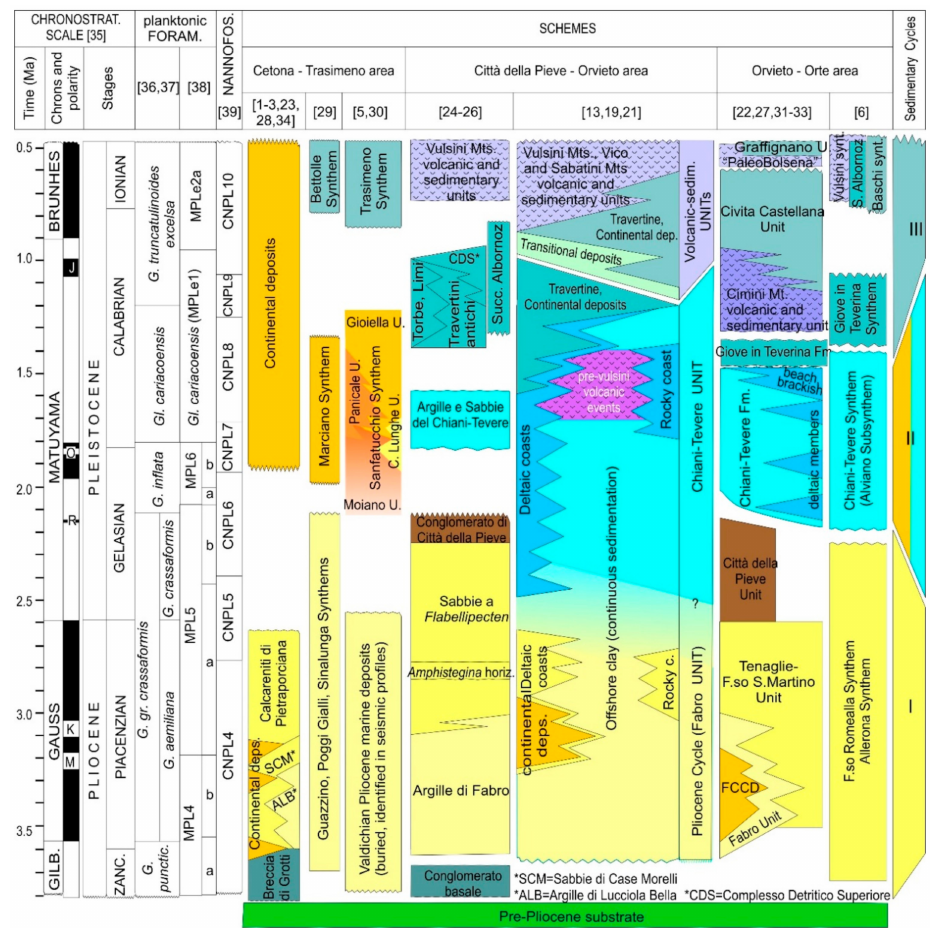
Figure 3. Comparison of lithostratigraphic schemes for the study